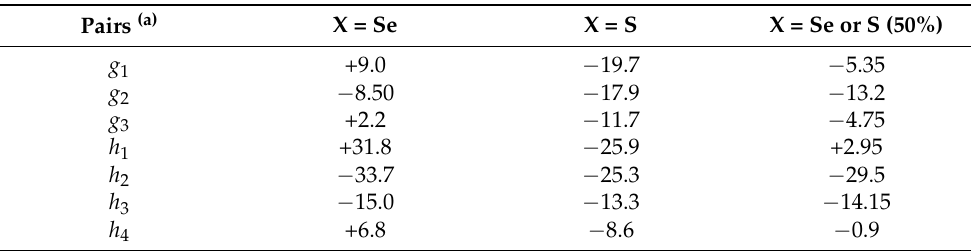
Table 1. Estimated overlap integrals ( S STF × 10 3 /dimensionless) in α -STF 2 I 3 . HOMO-HOMO overlaps between adjacent STF radical